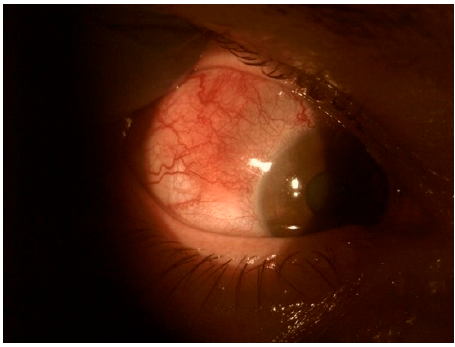
Figure 1. Scleritis.